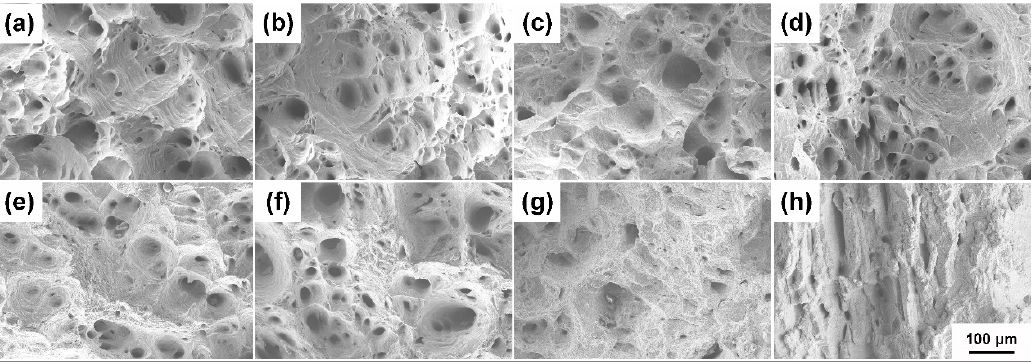
Figure 10. The SEM fractographs of the specimens tested in 950 °C ( a ), 1050 °C ( b ), 1150 °C ( c ), 1250 °C ( d ) at strain rate of 0.5 s −1 , and tested in 950 °C ( e ), 1050 °C ( f ), 1150 °C ( g ), 1250 °C ( h ) at strain rate of 5 s −1 .